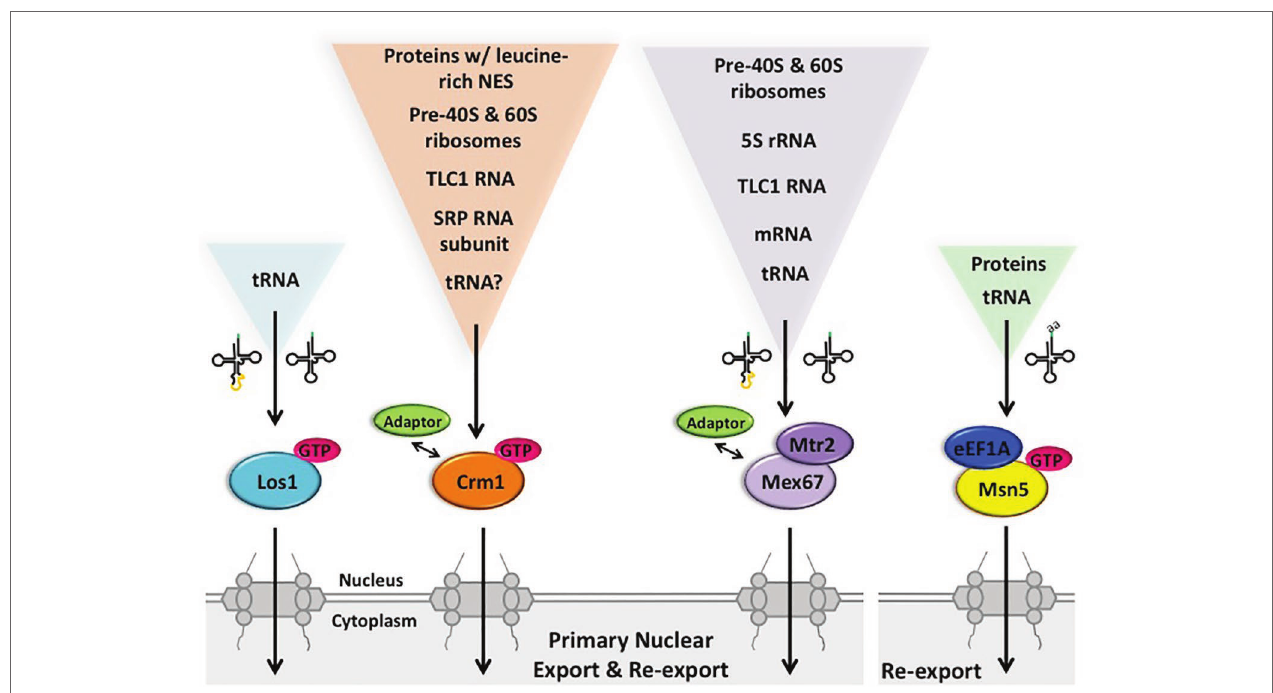
FIGURE 5 | The multiple pathways for budding yeast primary tRNA nuclear export and re-export are also utilized for the export of other RNA and protein species. Primary export and re-export of tRNAs from the nucleus to the cytoplasm occurs via Ran-dependent and Ran-independent exporters, specifically Los1, Mex67- Mtr2 and possibly Crm1 (left), which interact with both spliced and unspliced tRNAs. Msn5, however, selectively re-exports charged tRNAs, forming a quaternary complex with Ran-GTP and eEF1A (right). Although Los1 is a dedicated tRNA nuclear exporter, Mex67-Mtr2, Msn5 and Crm1 can export various RNA and/or protein species with the assistance of different adaptor proteins. GTP, Ran-GTP; SRP, signal recognition particle; NES, nuclear export